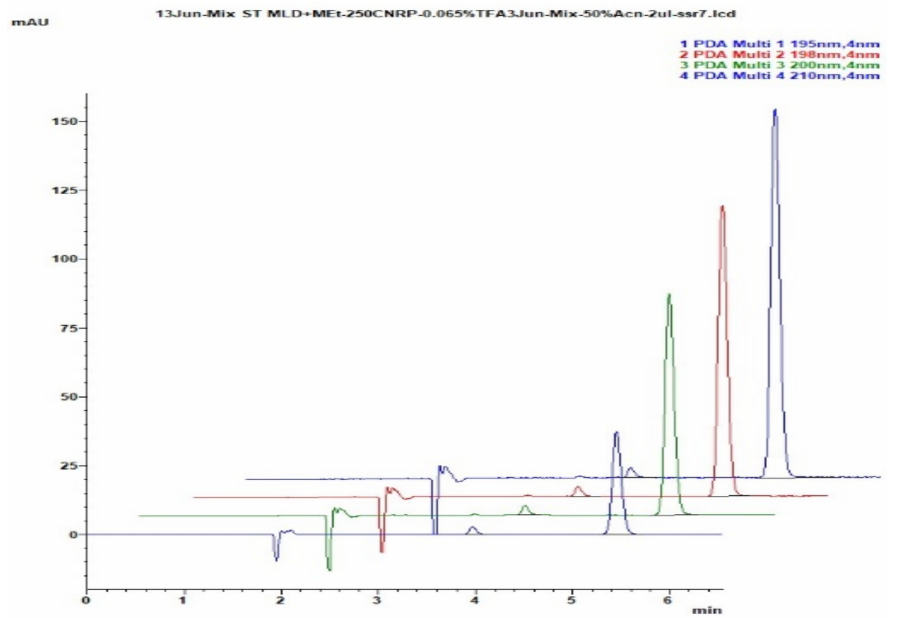
Figure 21. 4-channel multichannel view of full chromatograms with 50% ACN and 50% diluted TFA of samples with Waters Spherisorb CNRP-250 × 4.6 mm.